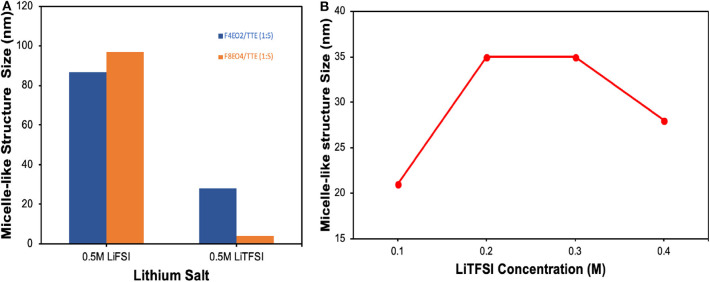
Size information extracted from SAXS measurement for (A) 0.5M salts dissolved in HFE/TTE 1:5 (v/v) as a function of salt and HFE additive identity. (B) Complex aggregate size as a function of LiTFSI salt concentration in F4EO2/TTE 1:5 (v/v).